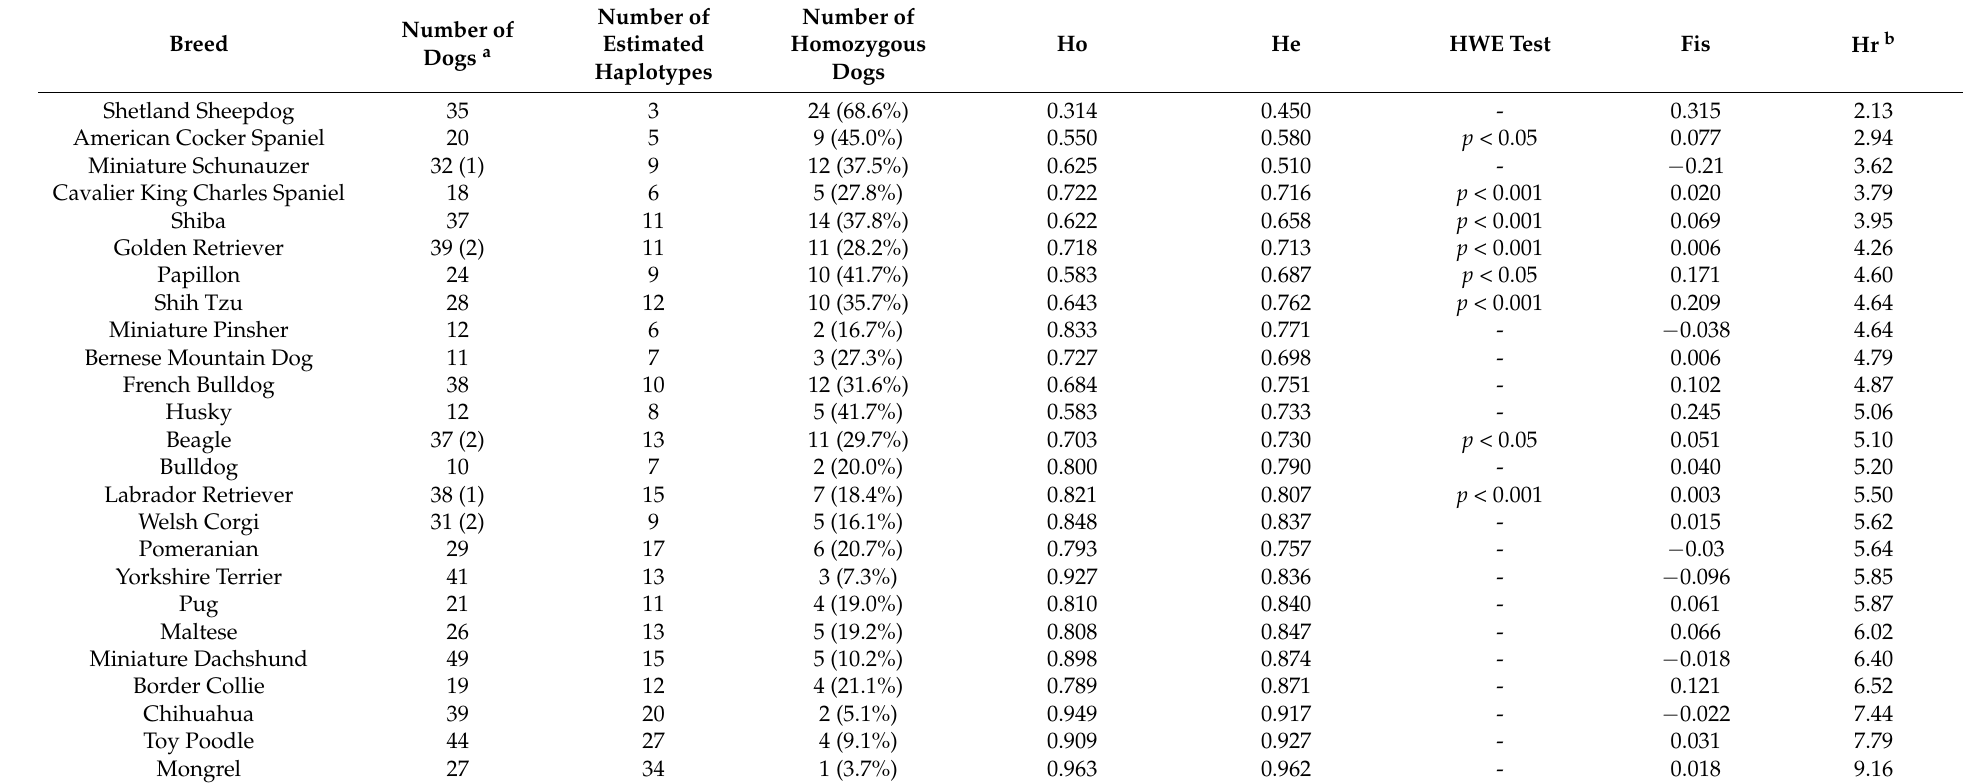
Table 5. Genetic diversity indices of 25 breeds and mongrels based on three loci (88-12/88L-DRB1) haplotypes. Number of Number of Number of Breed Estimated Homozygous Dogs a Haplotypes Dogs